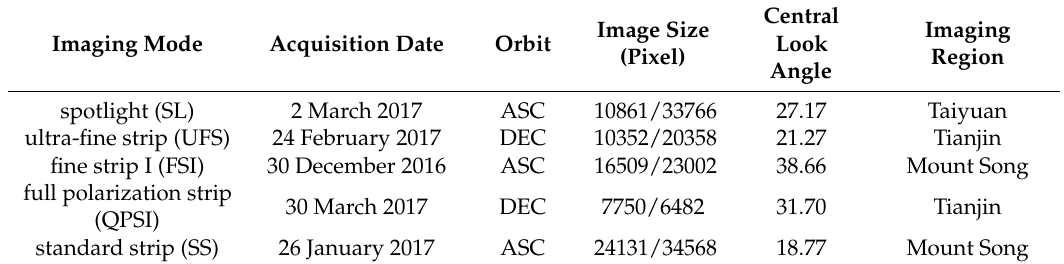
Table 2. Basic parameters of test area data for the five GF-3 SAR images over the study